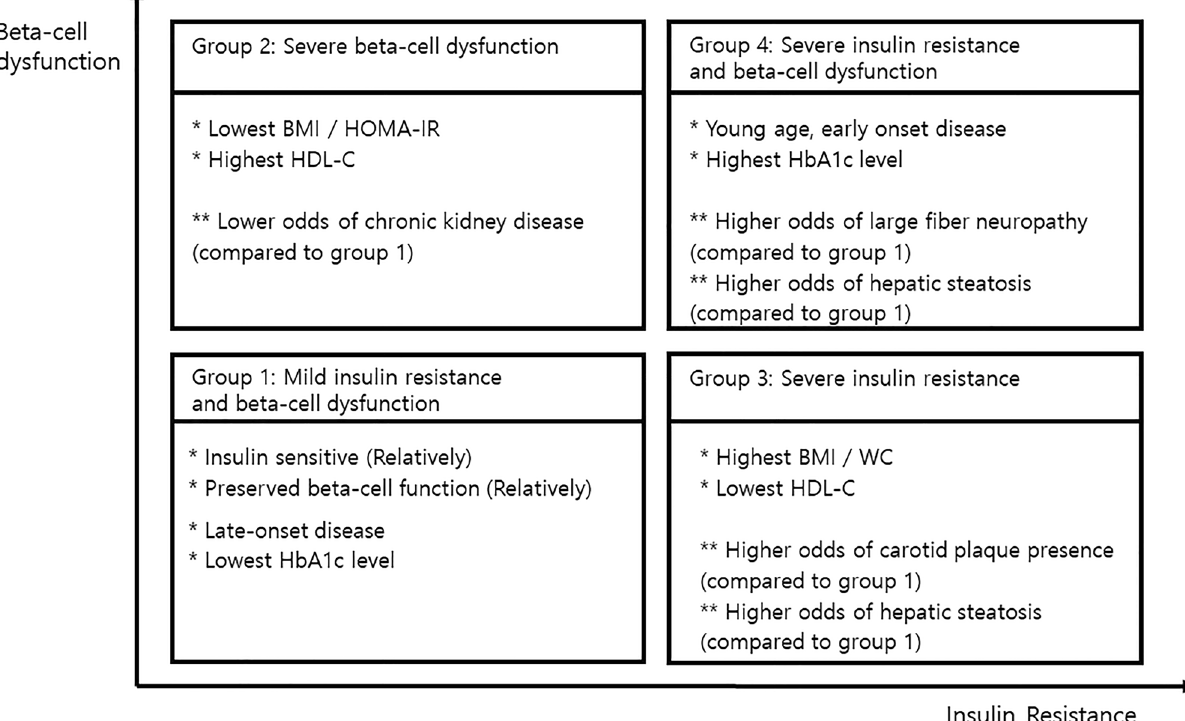
Figure 4. Summary of the group characteristics and risk of accompanying diabetic complications. DM diabetes mellitus, BMI body mass index, WC waist circumference, HOMA homeostatic model assessment, IR insulin resistance, HDL high-density